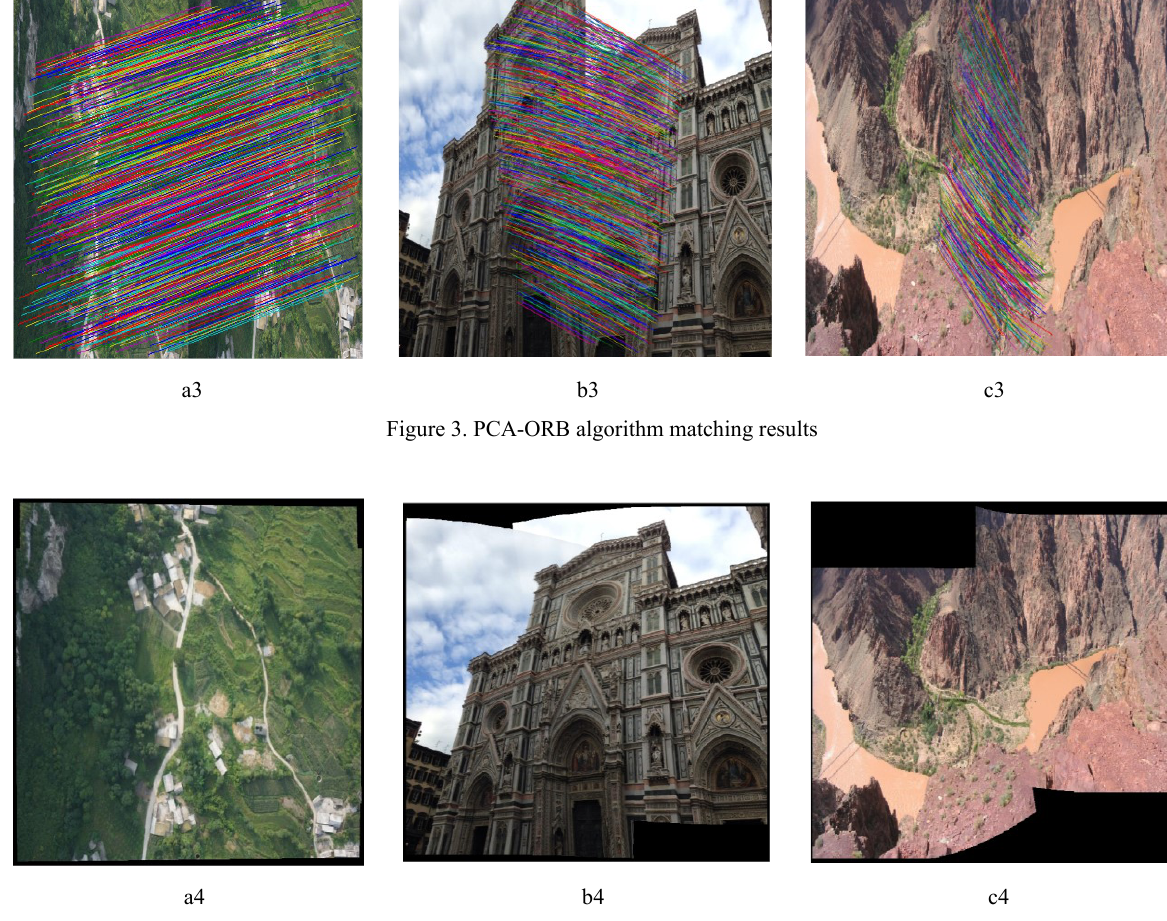
Figure 4. PCA-ORB algorithm stitching results Among, Matching rate = Matching logarithm / Total matching logarithm(Yang et al., 2018).